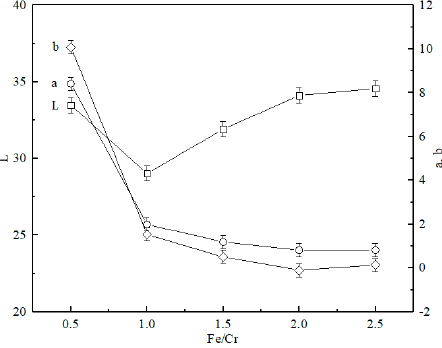
Figure 5. Effects of Fe/Cr molar ratio on the coloration of ceramic tiles sintered at 1150 °C for 30 min.